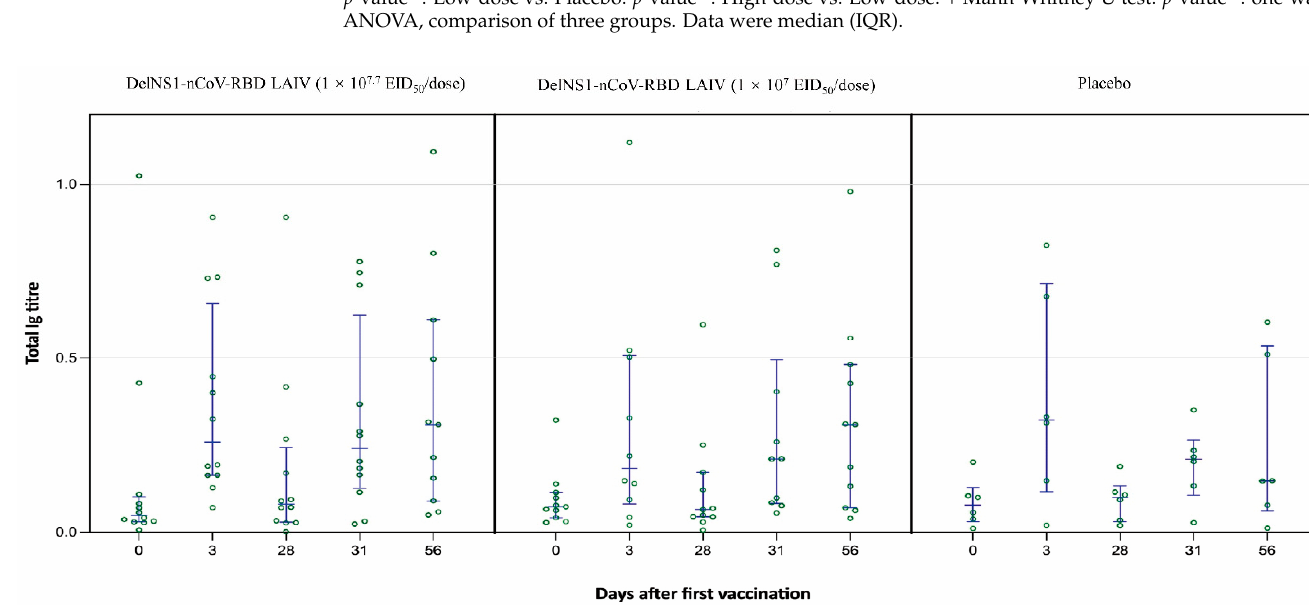
Table 4. Summary of saliva total Ig response.